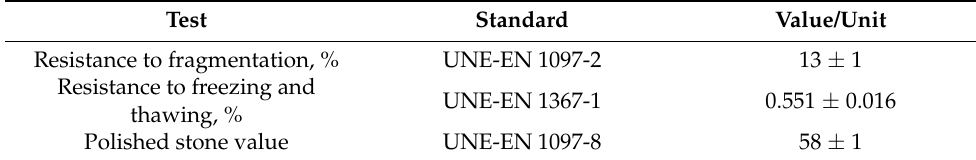
Table 4. Mechanical properties of electric arc furnace